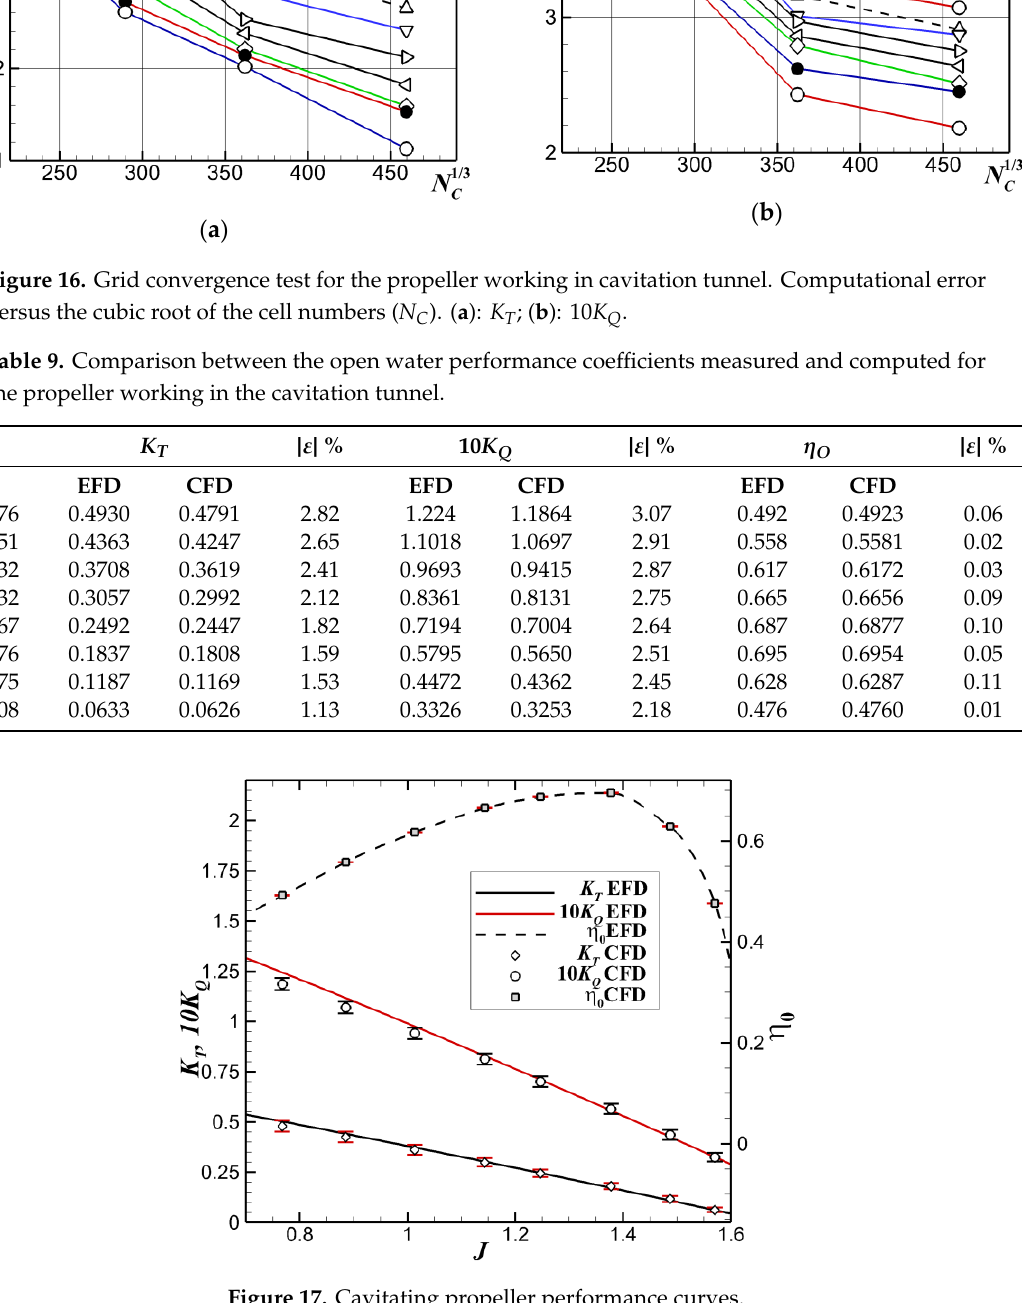
Figure 17. Cavitating propeller performance curves.